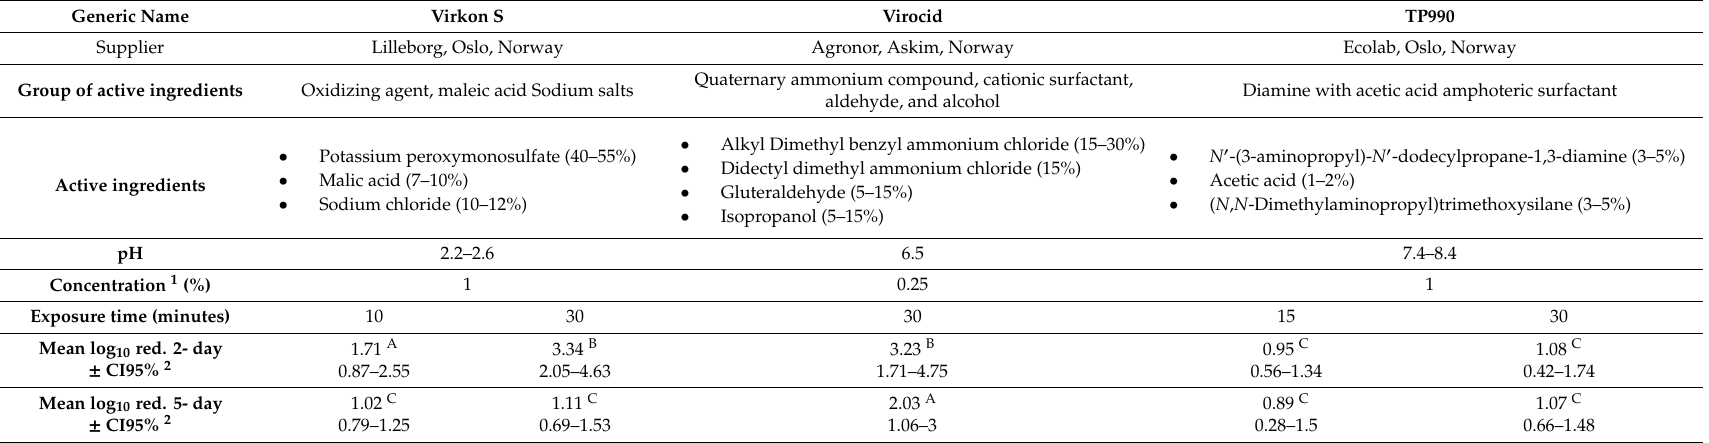
Table 2. The disinfectants included in the study, active ingredients, the concentration applied, the treatment time and the mean log 10 reduction for 2 and 5-day old